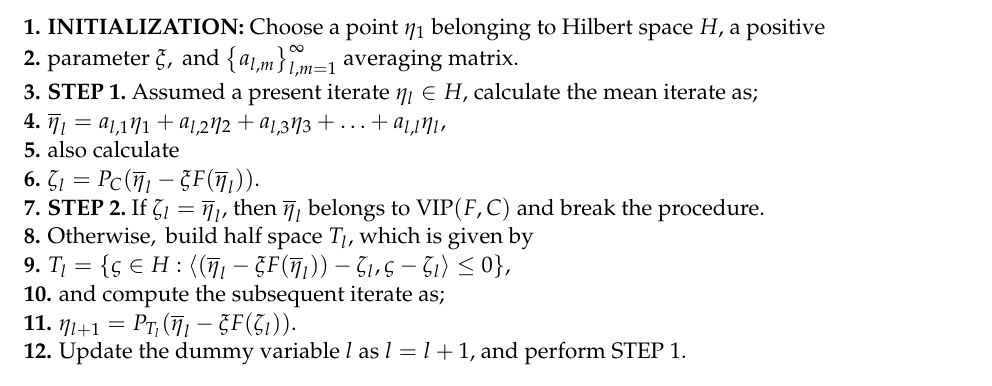
Algorithm 1: Solution procedure by Mann’s type mean extra-gradient